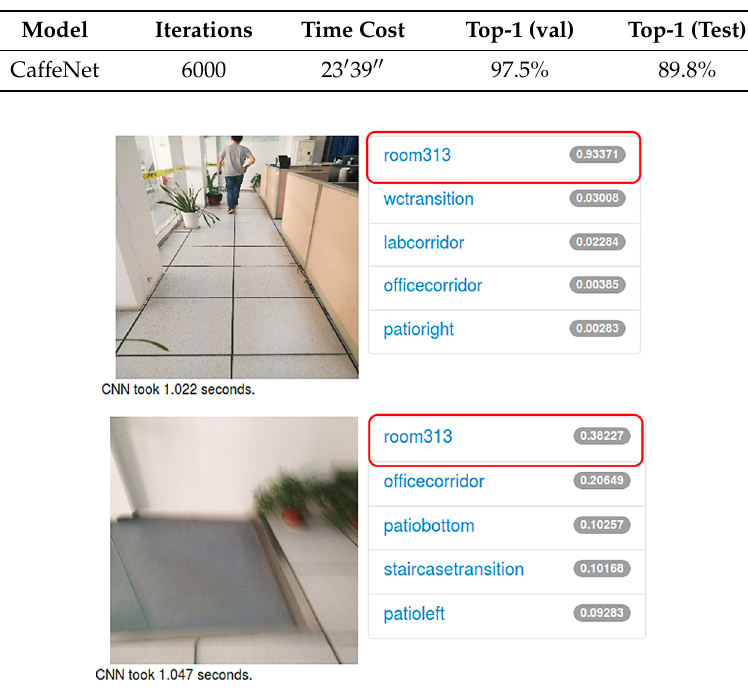
Figure 13. An example of indoor scene recognition with a bad-quality image. Both images were taken in room 313 of our lab. The second one is taken while a walking. The correct probabilities of these images are around 93.37% and 38.23% respectively.